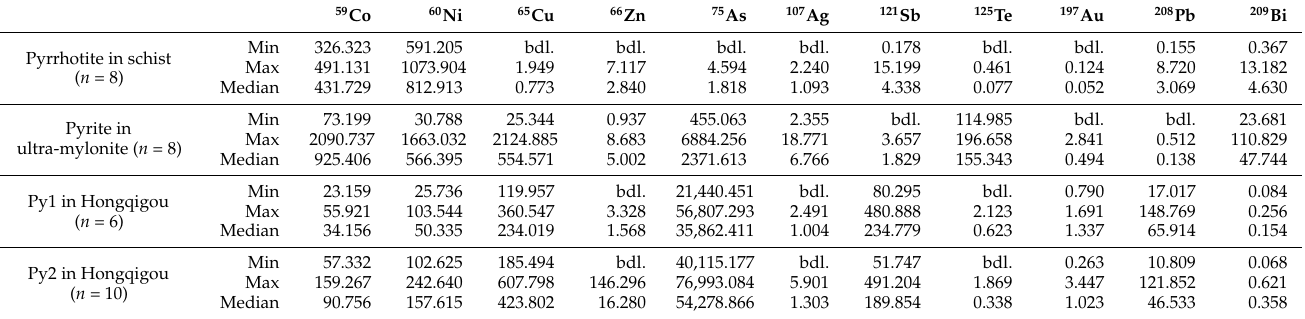
Table 2. The summarized LA-ICP-MS analytical results of trace elements for different generations of pyrite in each stage and pyrrhotite in schist of wall rock in the WGF (ppm, bdl = below detection